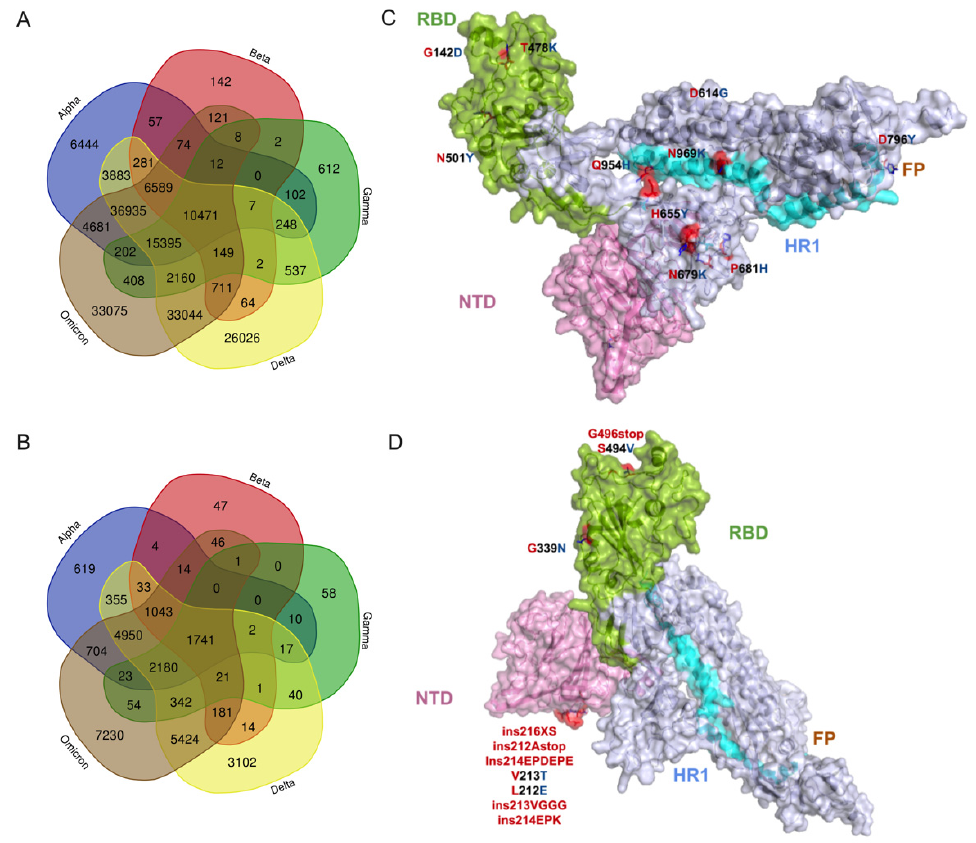
Figure 2. The common and exclusive mutations as well as structural changes in the proteome of Omicron variants. ( A ) Comparison of mutational profile data between 5 VOCs. In total, 12,002,213 sequences retrieved from GISAID’s EpiCoV database were used for this analysis. ( B ) Comparison of spike mutational profile data between 5 VOCs. ( C ) Illustration of the top 10 high-prevalence common spike glycoprotein mutations (D614G, frequency 99.50%; T478K, 83.28%; G142D, 73.15%; P681H, 60.31%; N501Y, 56.86%; H655Y, 51.69%; N679K, 50.54%; D796Y, 49.77%; N969K, 49.65%; Q954H, 49.54%) shared by 5 VOCs. ( D ) Illustration of the top 10 high-prevalence mutation and structural changes (G339N, 0.145%; ins216XS, 0.060%; ins212Astop; 0.373%; ins214EPDEPE, 0.021%; V213T, 0.020%; L212E, 0.020%; ins213VGGG, 0.016%; ins214EPK, 0.014%; G496stop, 0.010%; S494V, 0.010%) that are exclusive to Omicron variants on the monomer’s tertiary structure. Amino acid substitutions and structural changes in Omicron variants relative to the reference strain are represented in red stick models. Four domains in spike are highlighted as follows: (i) green for receptor binding domain (RBD), (ii) purple for N-terminal domain (NTD), (iii) brown for fusion peptide (FP) domain, and (iv) cyan for the heptad repeats-1 (HR1) domain. Grey is for inter-domain regions.